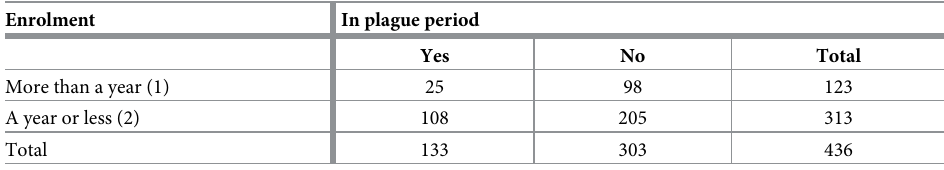
Table 3. Plague data for pestis secunda . Enrolment In plague period